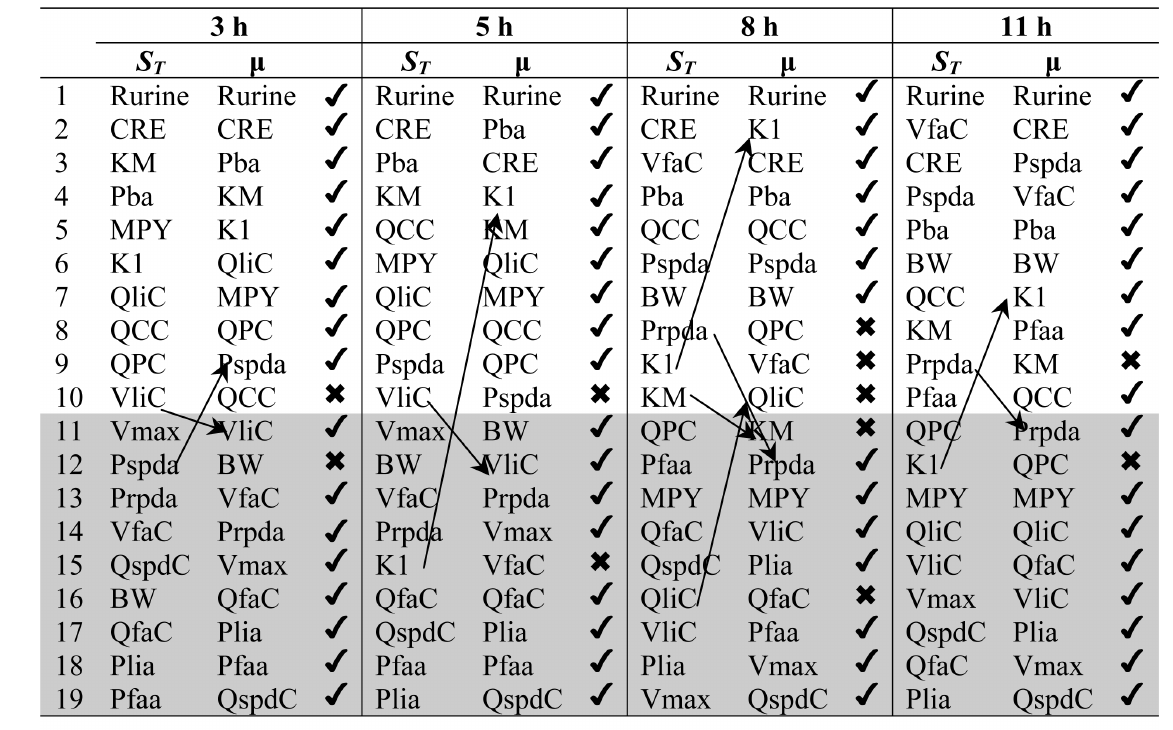
Table 4 | Comparison of ranking of model parameters for variance in C urine